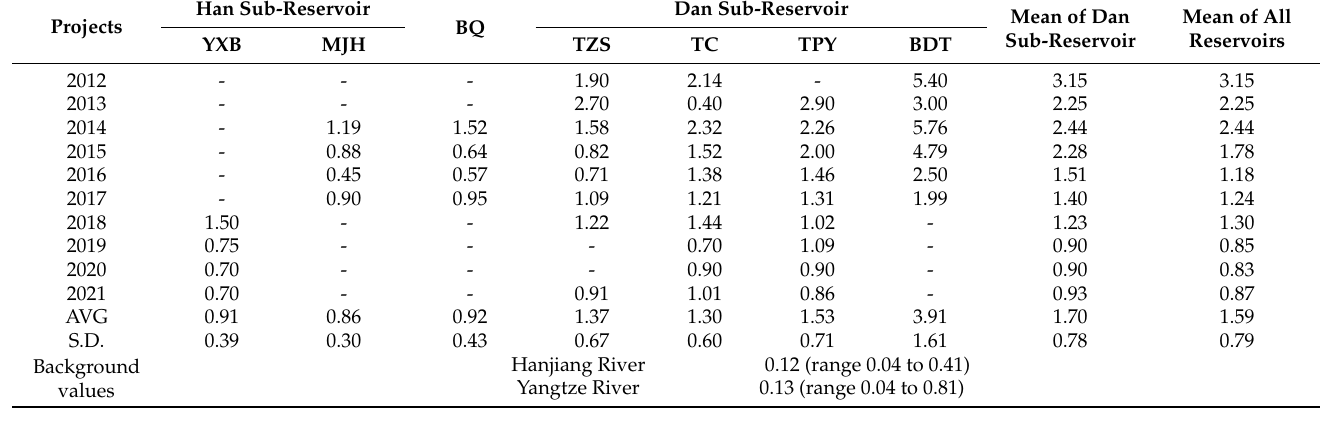
Table 1. Statistics of antimony monitoring results in Danjiangkou Reservoir water bodies ( μ g L − 1 ).